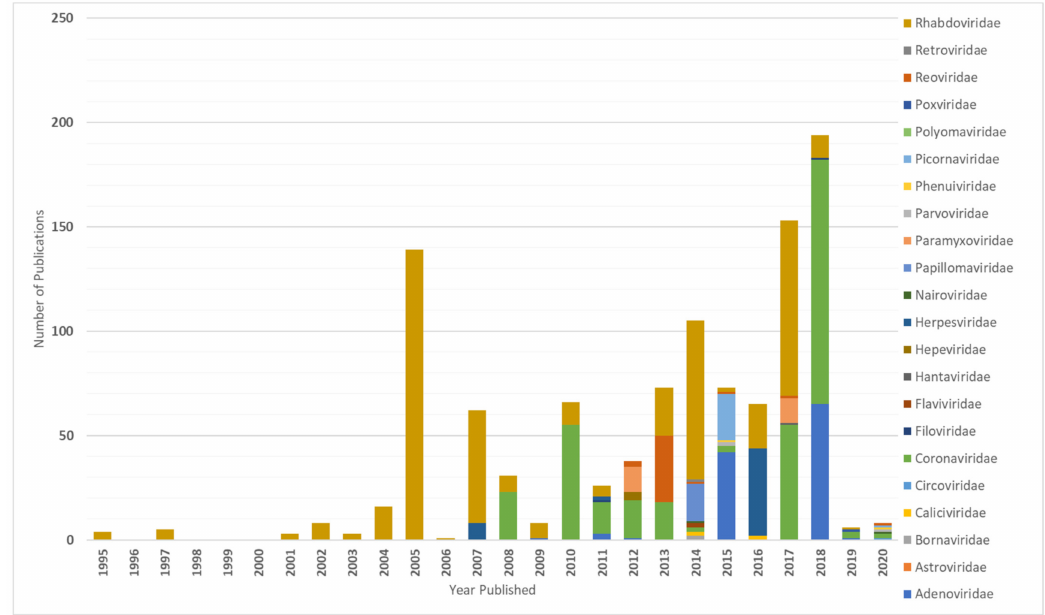
Figure 1. Number of published virus sequences over time, related to the respective viral family and order (DBatVir